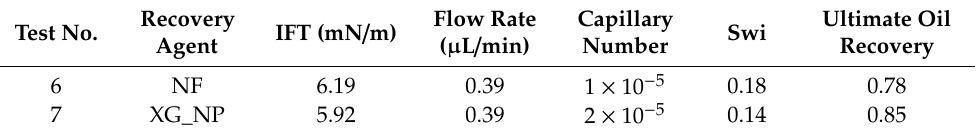
Table 6. Biopolymer and NF flow rate selection of 0.39 µ L / min.